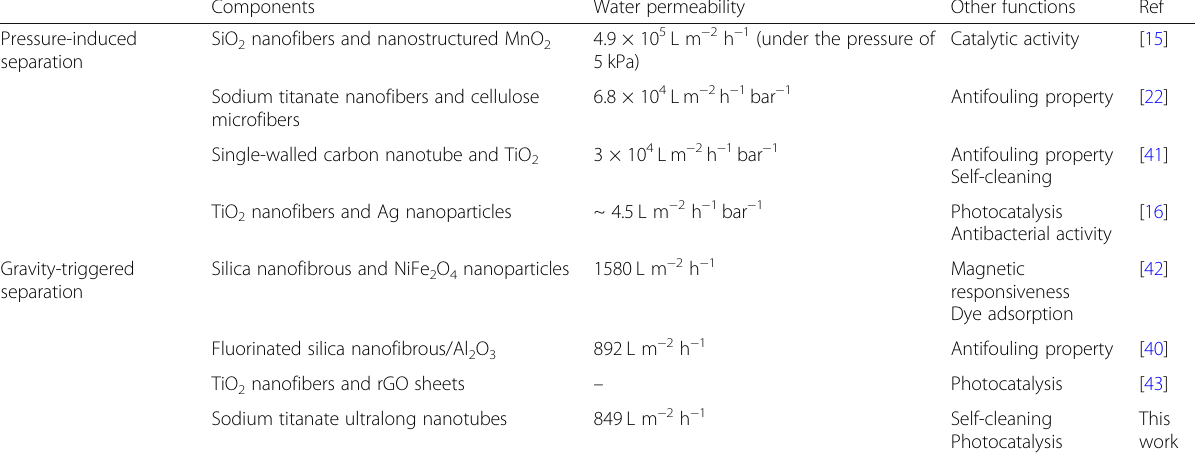
Table 2 Representative summary of oil/water separation membranes incorporating 1D inorganic